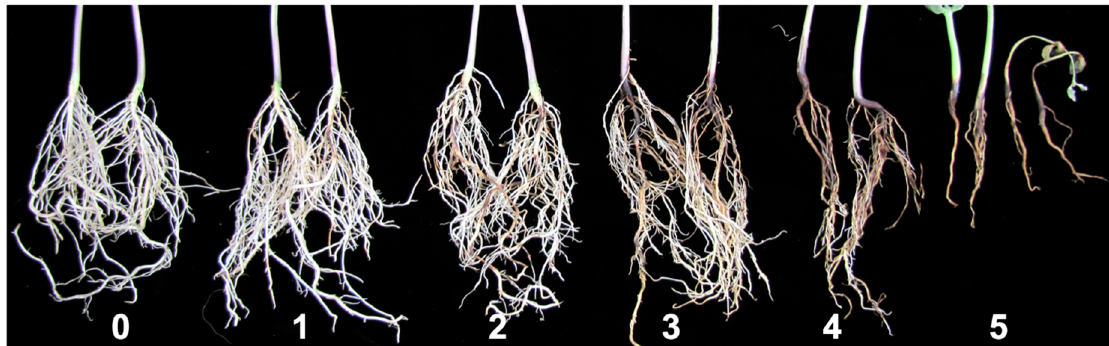
Figure 1. Visual scoring of disease severity for red crown rot. The photographs are representative examples of disease severity in control soybean cultivar “Enrei” after 14 days of inoculation with Calonectria ilicicola (UH2-1, 1%). The six-point rating scale was as follows: 0 = no visible symptoms, 1 = small brown necrotic lesions on the primary root, 2 = brown necrotic lesions extending all over the primary root and some lateral roots, 3 = root rot became evident with ≥ 50% root-loss by rot and severe brown necrosis in the underground stem, 4 = almost all roots rotted and lost, 5 = seedlings are dead.